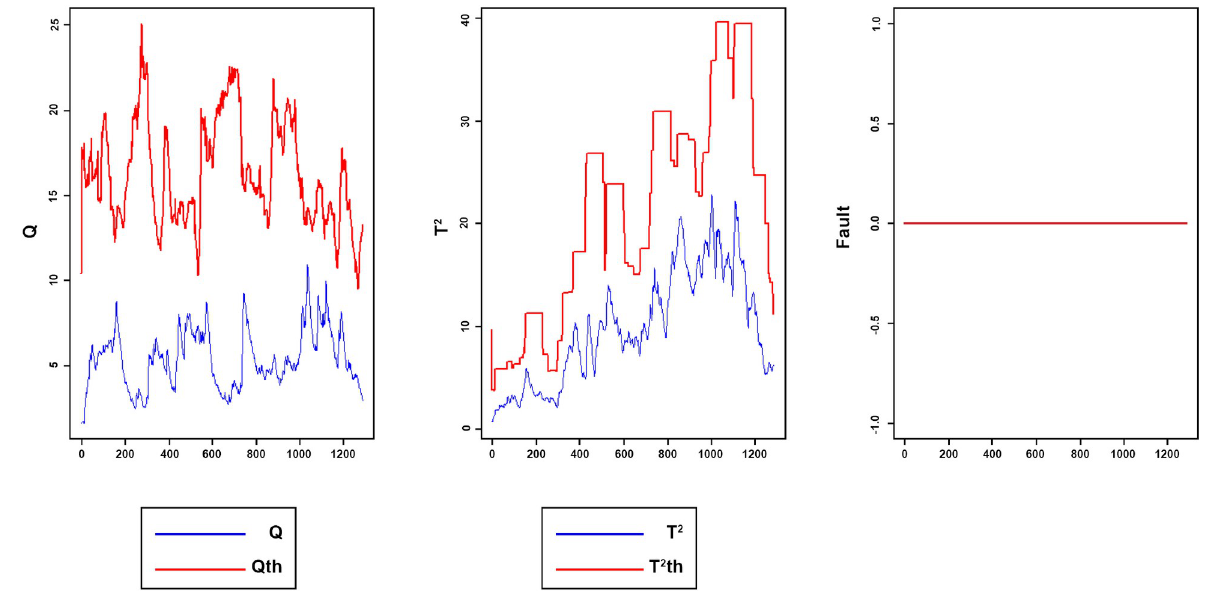
Fig 18. Monitoring performance of MWDPCA for TET data normal process.